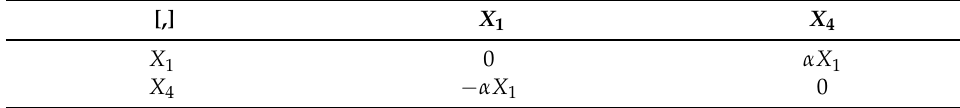
Table 5. Lie brackets for Cases 5 and 8.